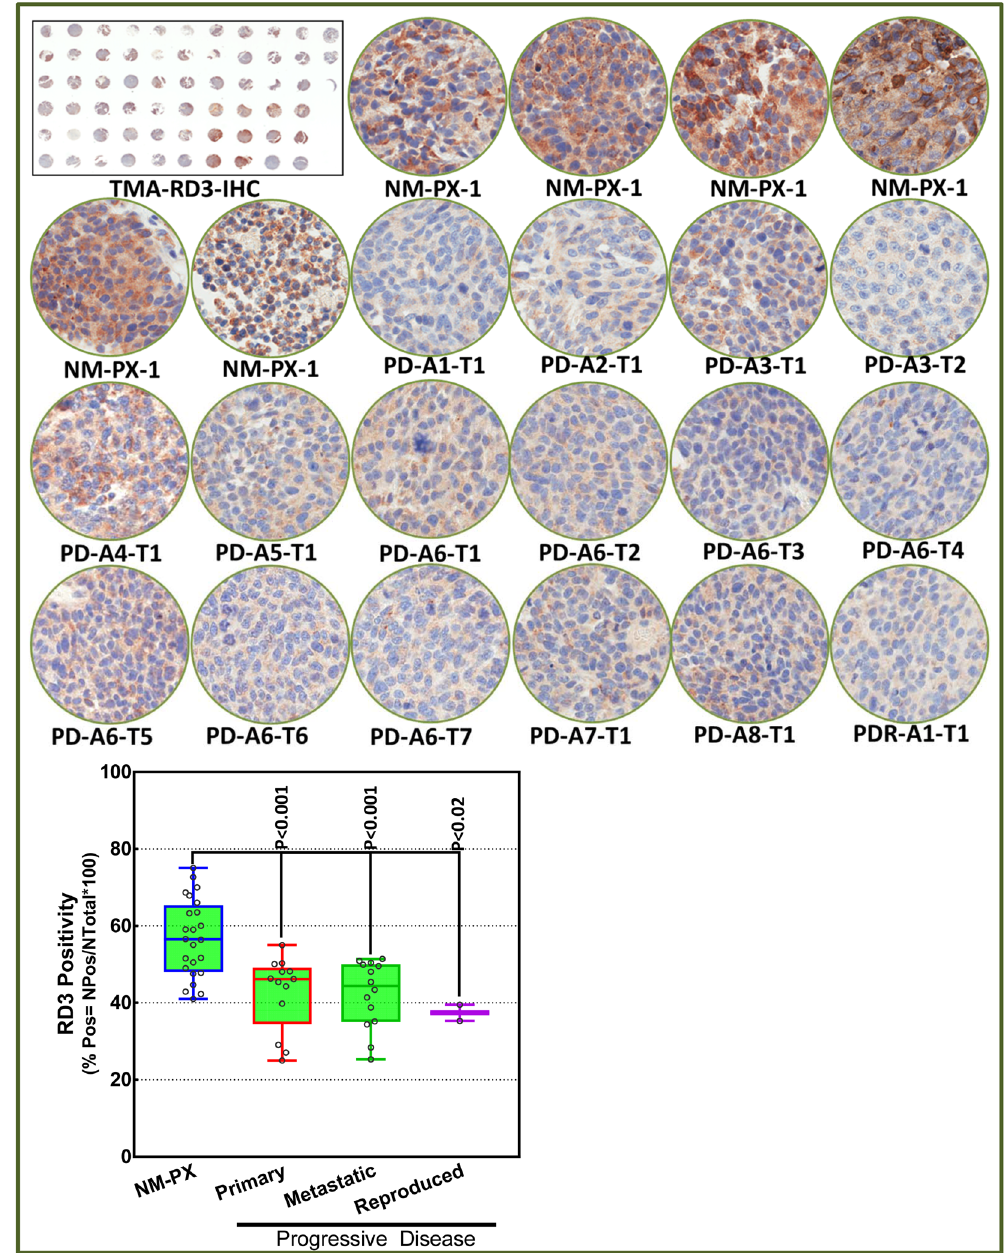
Figure 5. Loss of RD3 in mouse model of progressive disease (PD): ( A ) Thumbnail and constructed images (20 × ) from custom-archived TMA immunostained for RD3 showing localization and expression levels in primary and metastatic sites of mice with PD compared with the primary xenografts in mice without PD. Side Panel . Aperio TMA analysis coupled with group-wise comparison (GraphPad) showing significant loss of RD3 in primary and metastatic site tumors of PD mice and in reproduced disease with MSDACs compared with primary xenografts from mice without